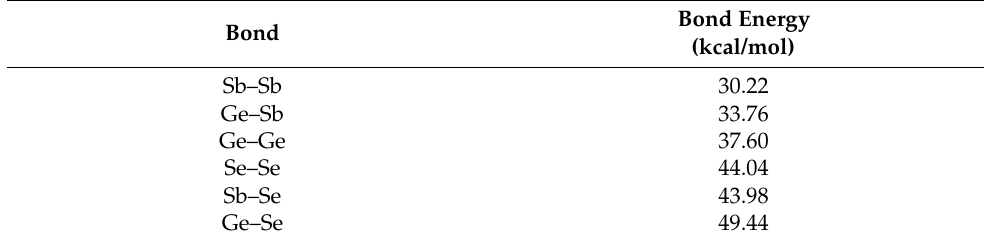
Table 4. Bond energies in Se-Ge-Sb elements of different